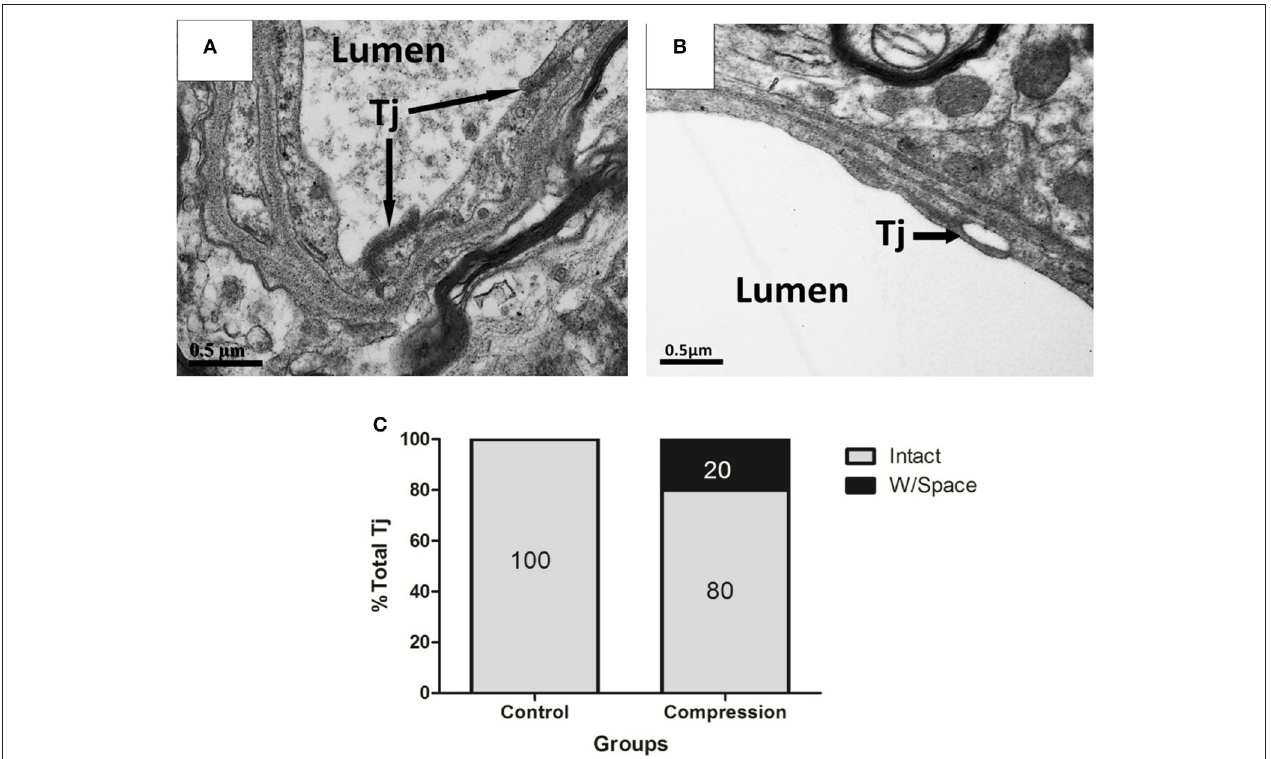
FIGURE 5 | EMs of TJs in ECs from control (A) , and compression group (B) . Structurally abnormal TJs that contain large gaps (black arrows) within compressed regions (B) . Histogram shows the percentage of intact TJs in the two groups (C) . Percentages were based on the analysis of 30 TJs from 12 rats per group. Tj, tight